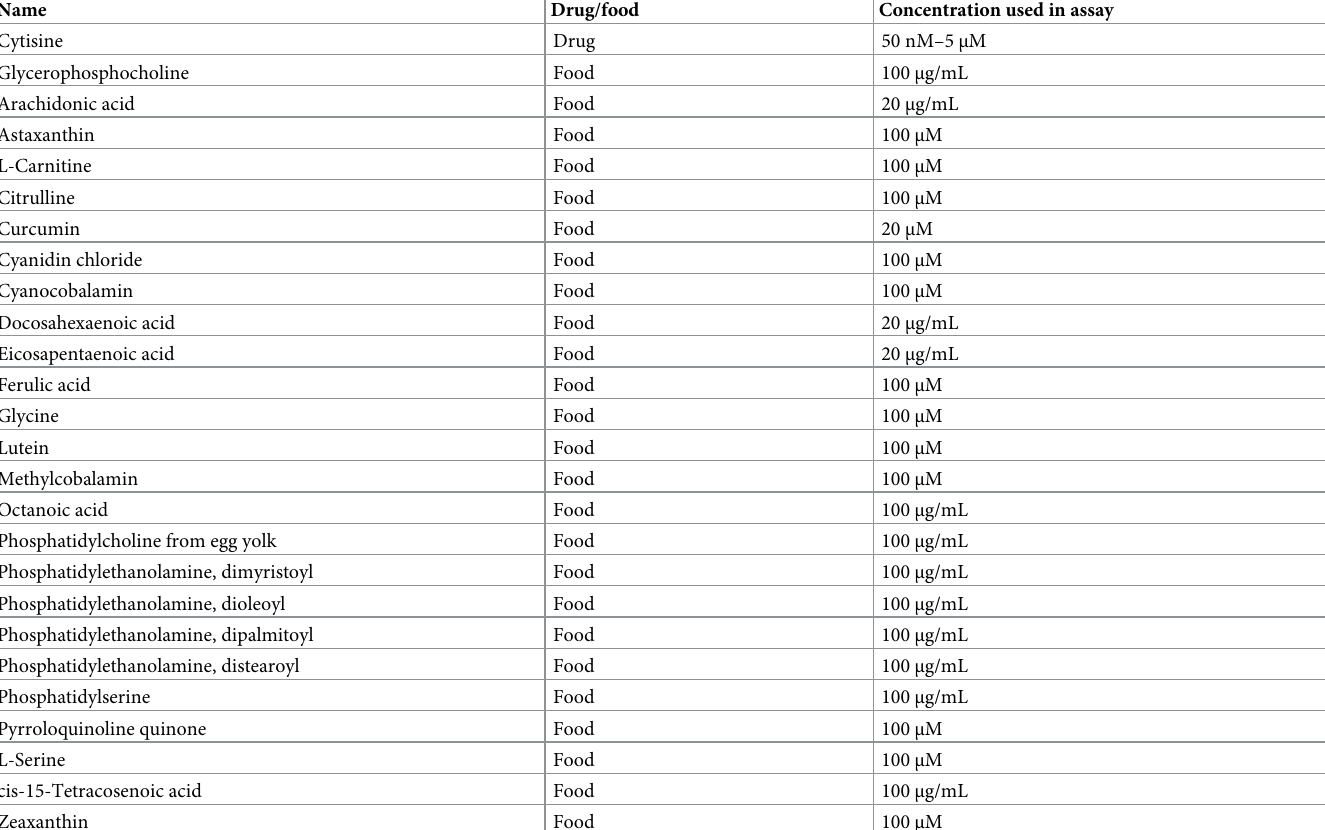
sostigmine [32], we consider that our model can sensitively detect the extracellular ACh fol- lowing AChE inhibition. Interestingly, using physostigmine, the detection of extracellular Table 6. A drug compound and food constituents that did not increase extracellular or intracellular ACh levels in our cell-based